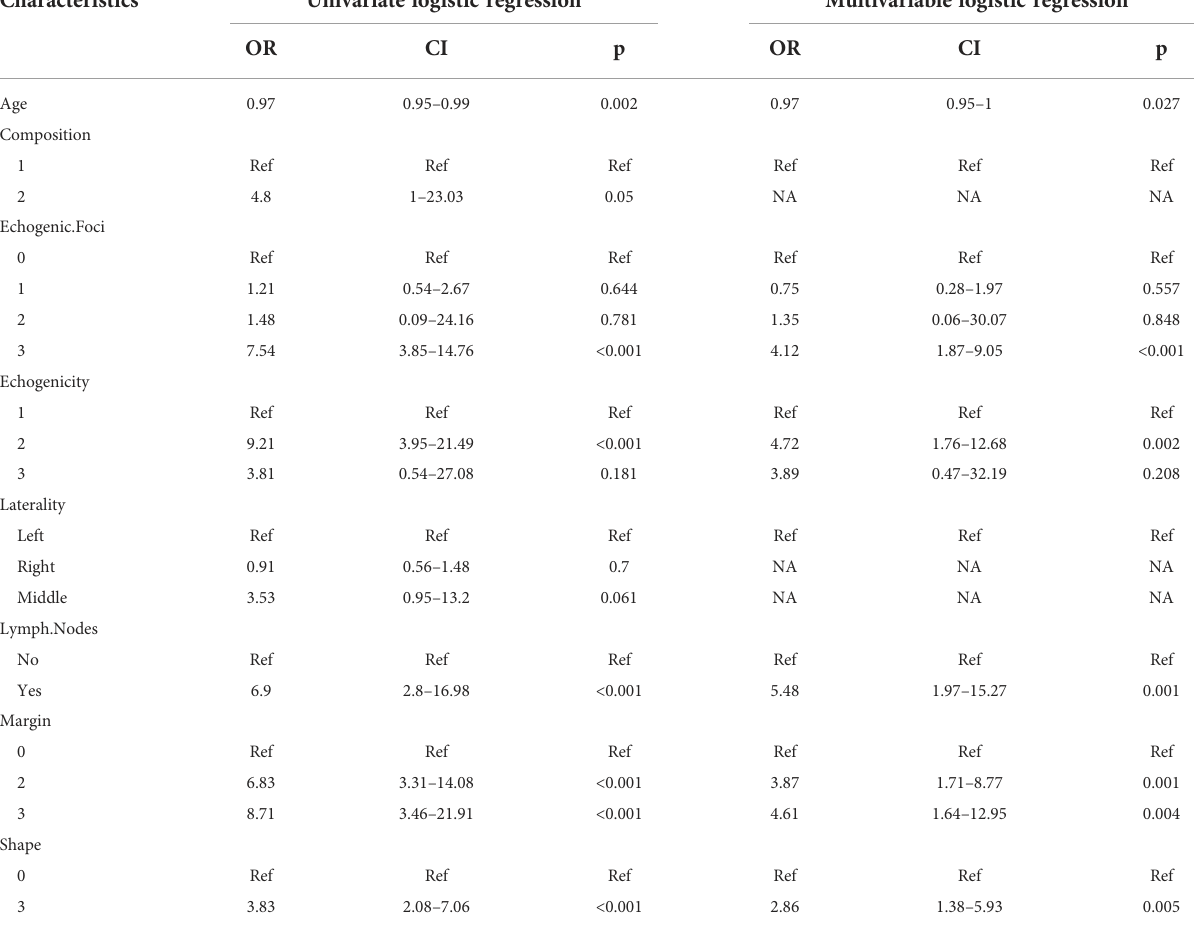
TABLE 1 The results of univariate and multivariable logistic regression.